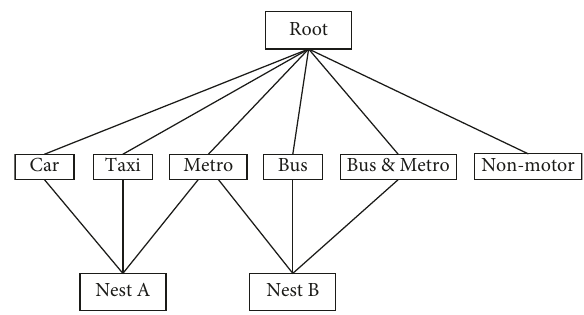
Figure 1: Nesting structure of the CNL